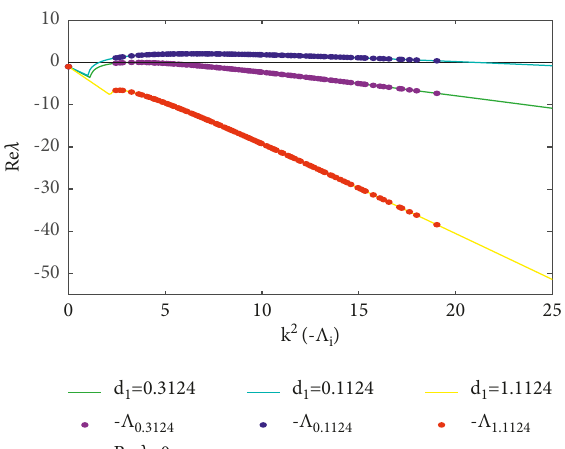
Figure 4: Linear stability analysis. The relationship between Re λ about − Λ and p � 0 . 1 ,d